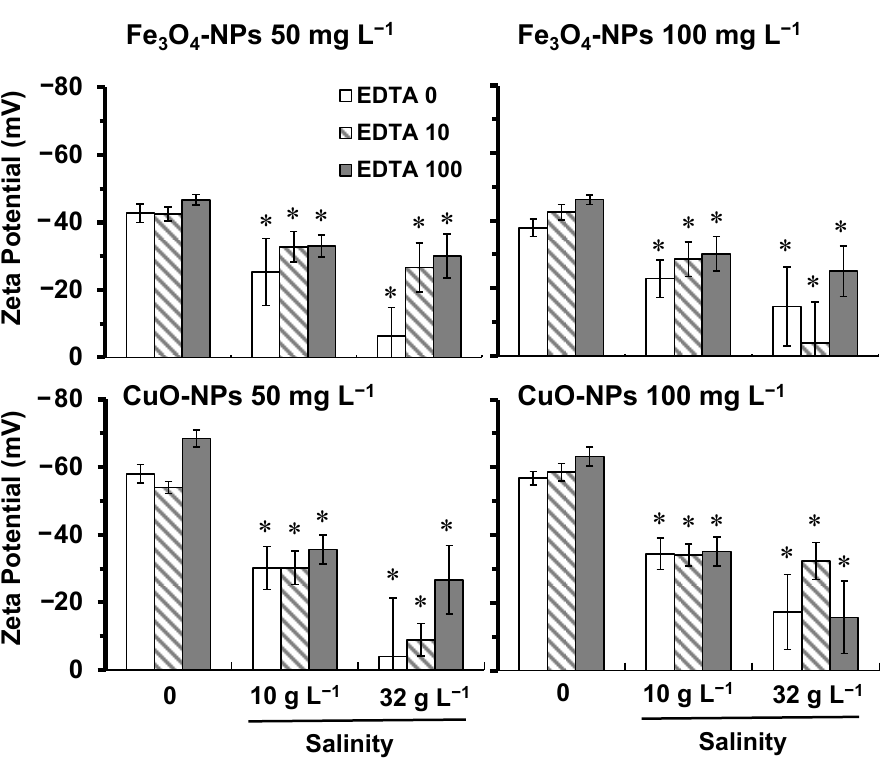
Figure 1. Zeta potential values of NPs in HSM (no salt added), and under two salinity conditions (10 and 32 g L − 1 ). NPs were also exposed to EDTA concentrations: 0 mg L − 1 (white), 10 mg L − 1 (dash) and 100 mg L − 1 (gray). (*) For both NPs, the salinity significantly decreased ( p < 0.05) the values of the zeta potential compared to the respective controls (no salt added), even in the presence of EDTA (determined by one-way ANOVA and Tukey post-hoc test).